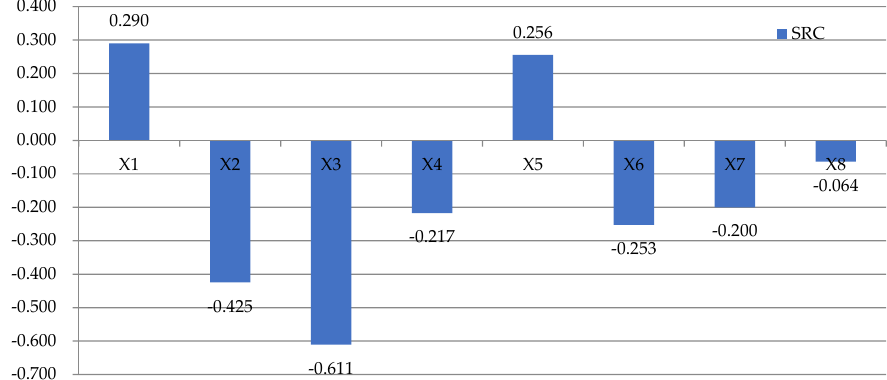
Figure 11. The SRCs of input parameters of the case study. X1 = L( d –1, h ); X2 = T( h );X3 = T( h –1); X4 = T( h –2); X5 = T( h –3); X6 = RH( h ); X7 = RH( h –1); X8 = RH( h